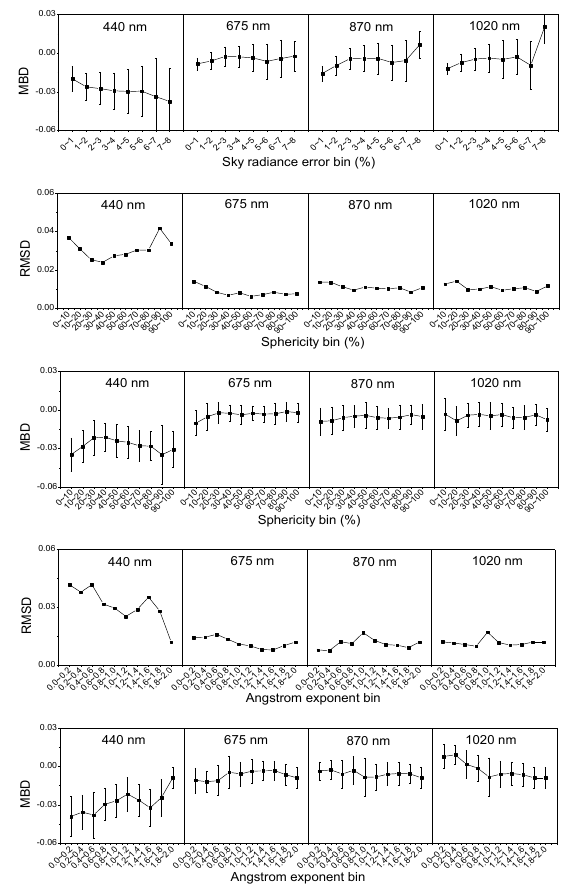
Figure 3 Aerosol asymmetry factor g deviations (RMSD, MBD and STD) of DVL and AERONET as a function of AOD (440 nm), SZ, Sky error, Sphericity and Ǻngström exponent, at 4 wavelengths of 440, 675, 870 and 1020 nm,